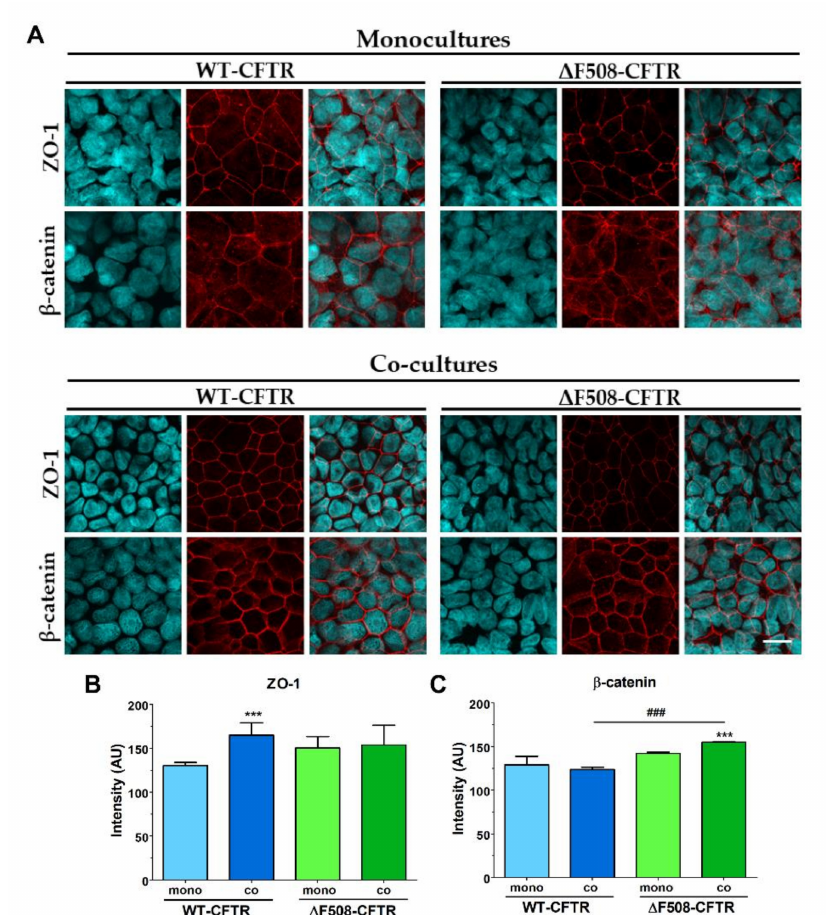
Figure 2. Immunostaining for junctional proteins zonula occludens-1 (ZO-1) and β -catenin after 10 days of monoculture or co-culture with endothelial cells ( A ). The mean pixel intensity of ZO-1 ( B ) and β -catenin ( C ) staining at the cell border. Values are presented as means ± SD, n = 3–6 / group. Statistical analysis: 2-way ANOVA and Bonferroni test. *** p < 0.001 compared to the monocultures. ### p < 0.001 compared to WT-CFBE cells. Red color: immunostaining for junctional proteins. Cyan color: staining of cell nuclei. Bar: 25 µ